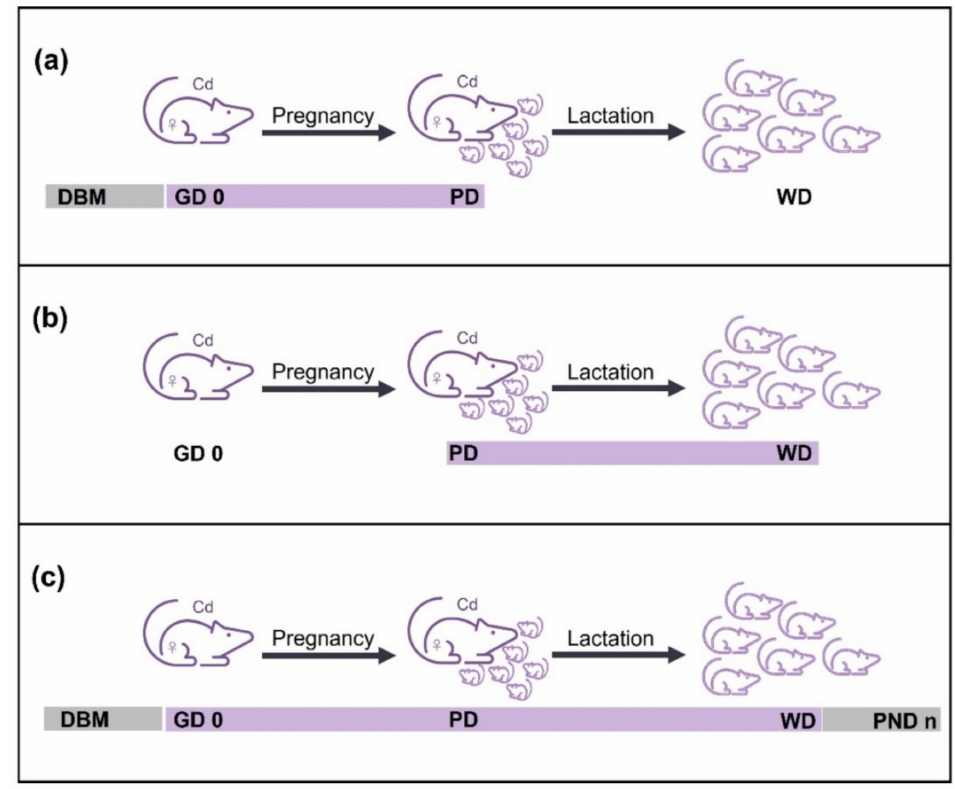
Figure 2. Cd exposure schemes. ( a ) Administration of Cd during pregnancy period, from days before mating (DBM) or gestation day zero (GD 0) to the parturition day (PD). ( b ) Cd exposure during lactation period, from PD to the weaning day (WD). ( c ) Scheme of Cd exposure during pregnancy–lactation, from DBM or GD 0 to WD or until offspring reached adulthood (PND n). Purple line represents Cd administration described by most of the authors, whereas gray line indicates Cd exposure mentioned by some